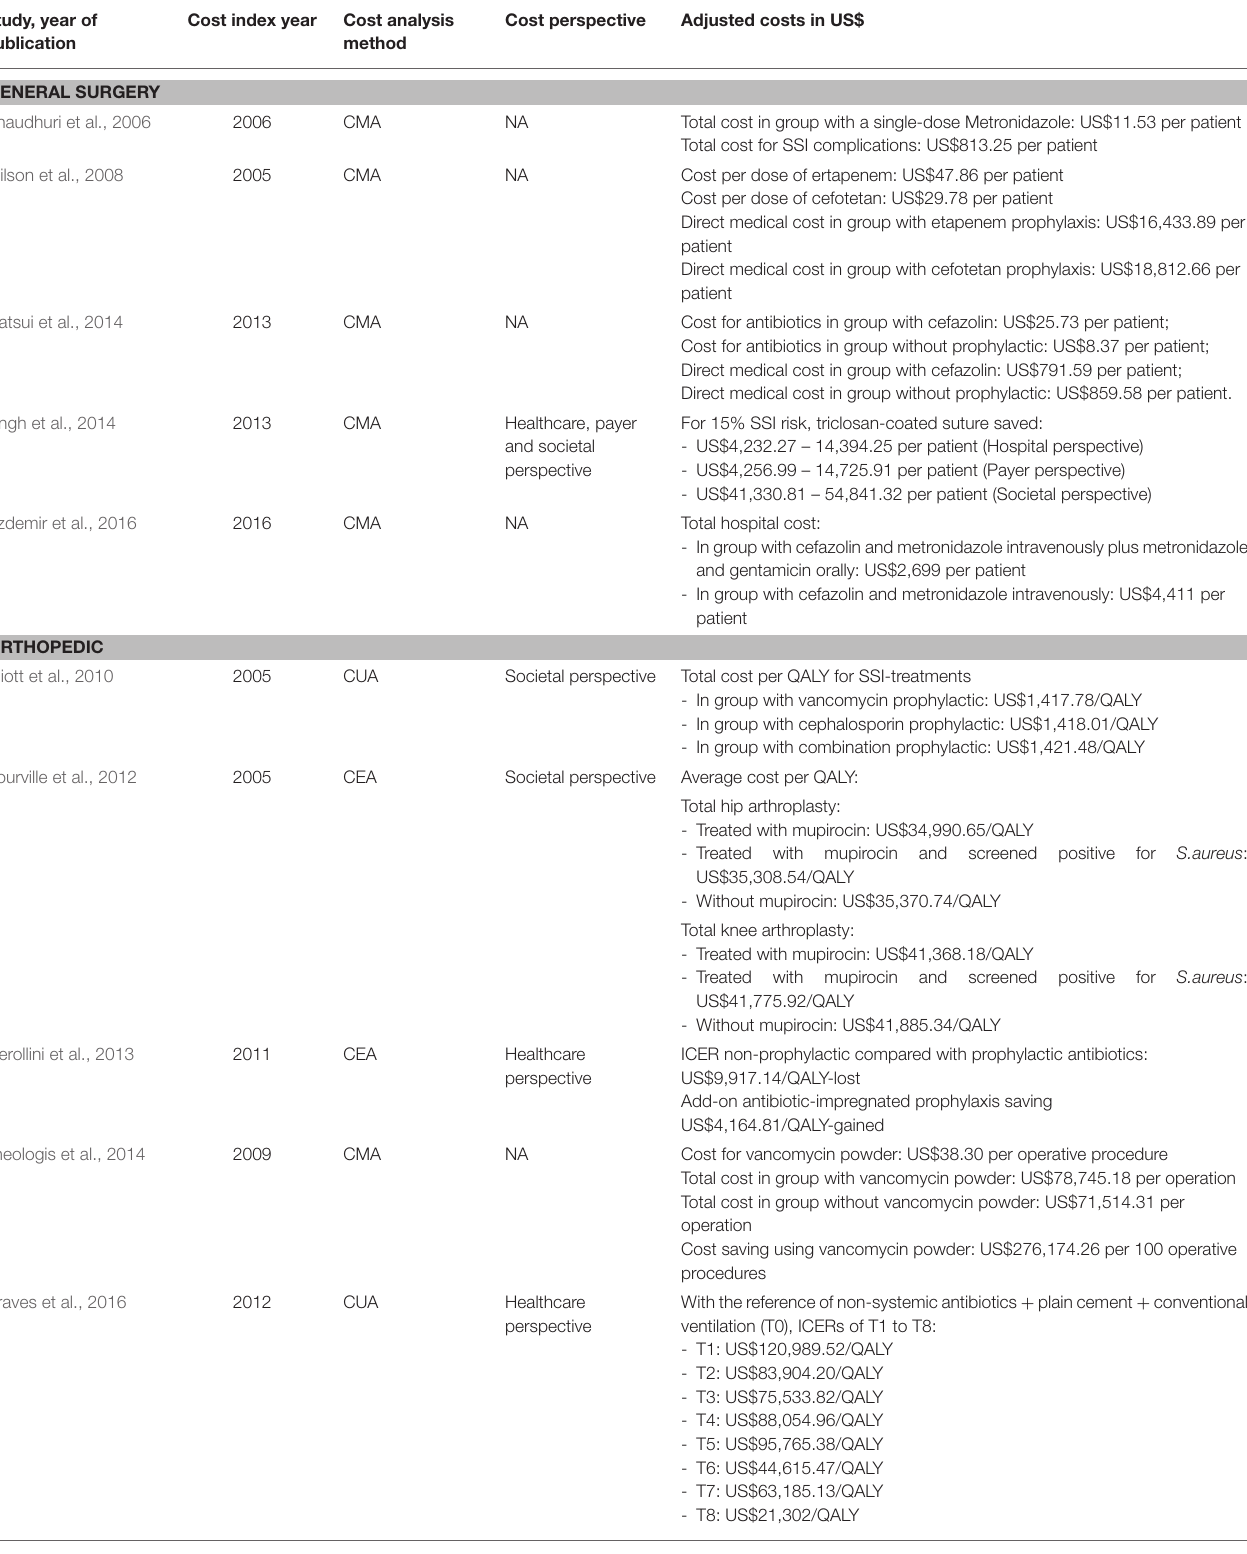
TABLE 3 | Comparisons of included studies on reporting of cost index year, cost analysis method, cost perspective, and costs (adjusted to US$ at 2015